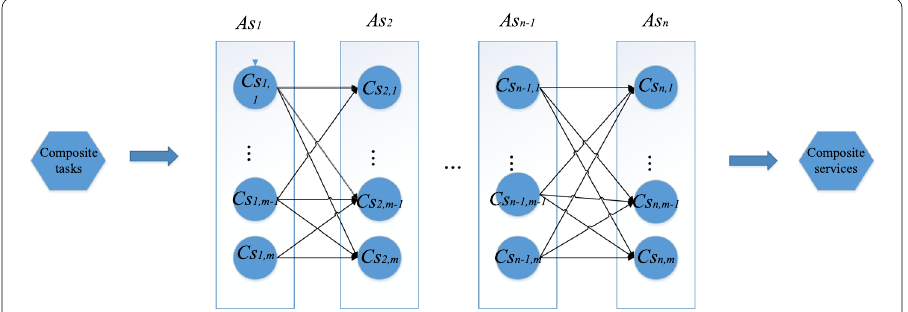
Fig. 1 The model of service